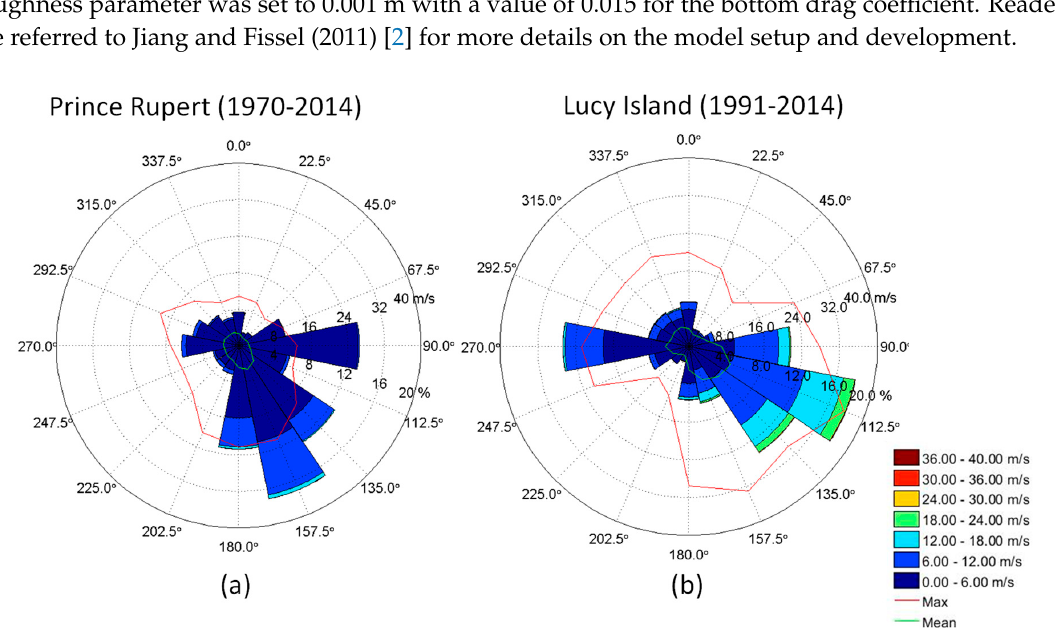
Figure 5. Compass rose plots for wind speed and direction distributions measured at ( a ) Prince Rupert Airport and ( b ) Lucy Island (see Figure 1). The wind datasets were obtained from the Meteorological Service of Canada, Environment and Climate Change Canada.